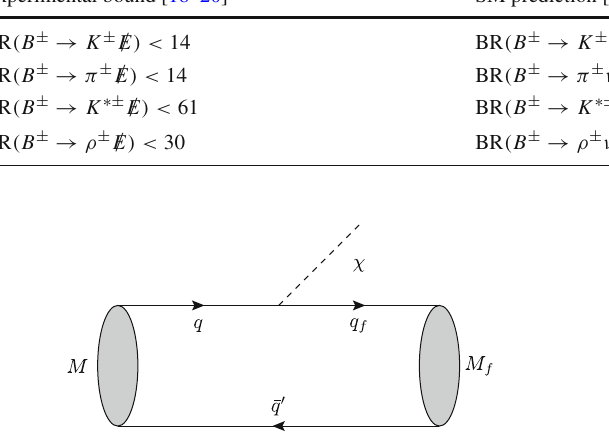
Table 1 The branching ratios (in units of 10 − 6 ) of B meson decays involving missing energy Experimental bound [18–20] SM prediction [50–53]